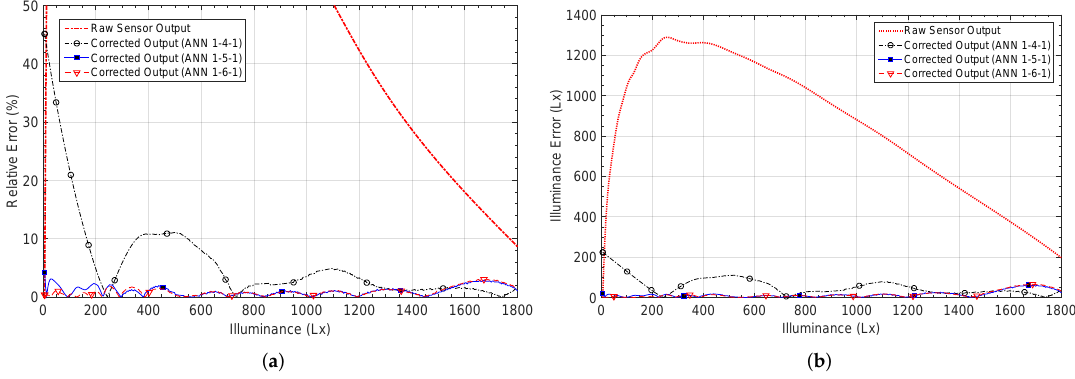
Figure 15. Calculated errors by considering the non-linear characteristic 3 (NL3): ( a ) relative error e r and ( b ) illuminance estimation error e L